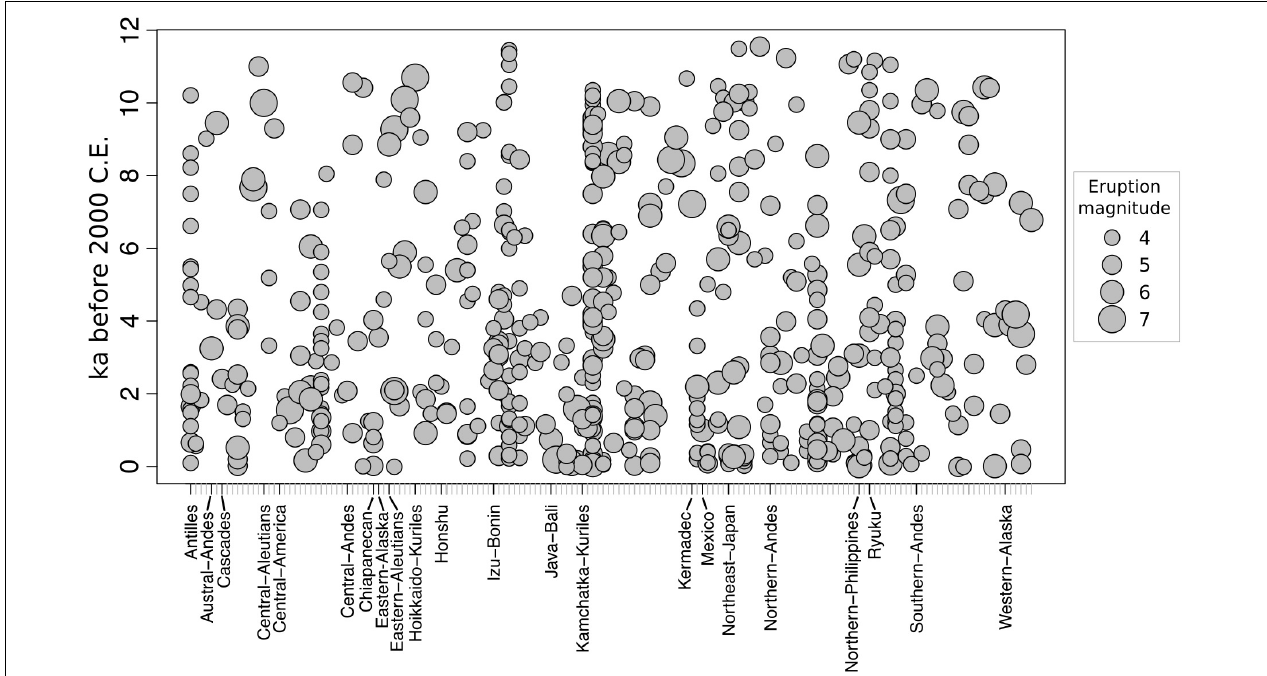
FIGURE 2 | Eruption record for all 162 volcanoes in this analysis, showing no clear bias in event age or geographical location with respect to eruption magnitude. The volcanoes are ordered alphabetically according to the classification by volcanic arc in Figure 1 . The order of volcanoes is the same order as in the Supplementary Table A1